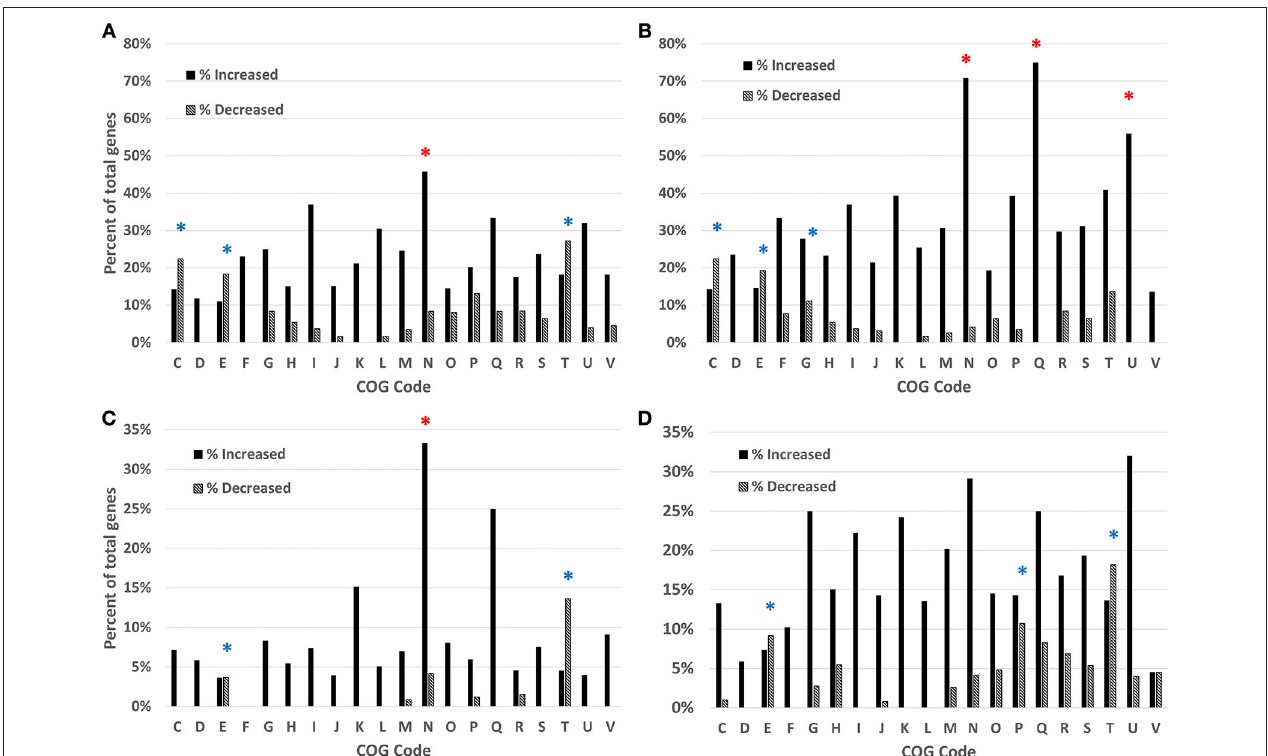
FIGURE 2 | Analysis of the differentially expressed genes based on COG function detected by RNAseq, gallbladder in vivo samples at 2 h (A) and 24 h (B) and bile in vitro samples at 2 h (C) and 24 h (D) . Clusters of Orthologous Groups (COG) categories are indicated on the x-axis, with the percentage of genes enriched shown on the y-axis. Black bars indicate increased expression, patterned bars indicate decreased expression. Red asterisks ( * ) indicate statistically significant enrichment ( p < 0.05) for genes with increased expression; blue asterisks ( * ) indicate statistically significant enrichment ( p < 0.05) for genes with decreased expression. COG category codes: C, Energy production and conversion; D, Cell cycle control, mitosis and meiosis; E, Amino acid transport and metabolism; F, Nucleotide transport and metabolism; G, Carbohydrate transport and metabolism; H, Coenzyme transport and metabolism; I, Lipid transport and metabolism; J, Translation; K, Transcription; L, Replication, recombination and repair; M, Cell wall/membrane biogenesis; N, Cell motility; O, Posttranslational modification, protein turnover, chaperones; P, Inorganic ion transport and metabolism; Q, Secondary metabolites biosynthesis, transport and catabolism; R, General function prediction only; S, Function unknown; T, Signal transduction mechanisms; U, Intracellular trafficking and secretion; V, Defense mechanisms; W, Extracellular structures.